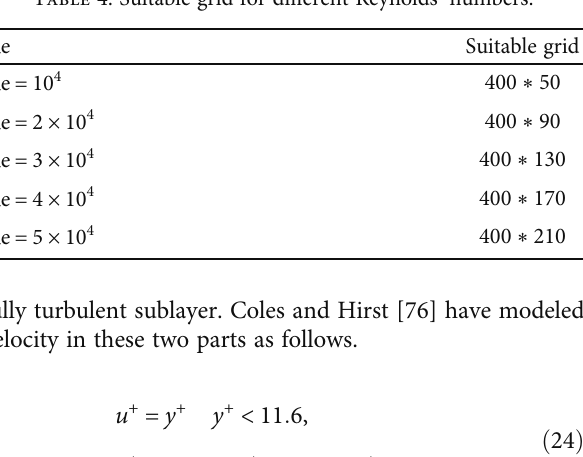
Figure 3: Comparison between values of u + in the present work with Coles and Hirst [76]. Table 4: Suitable grid for di ff erent Reynolds ’ numbers.